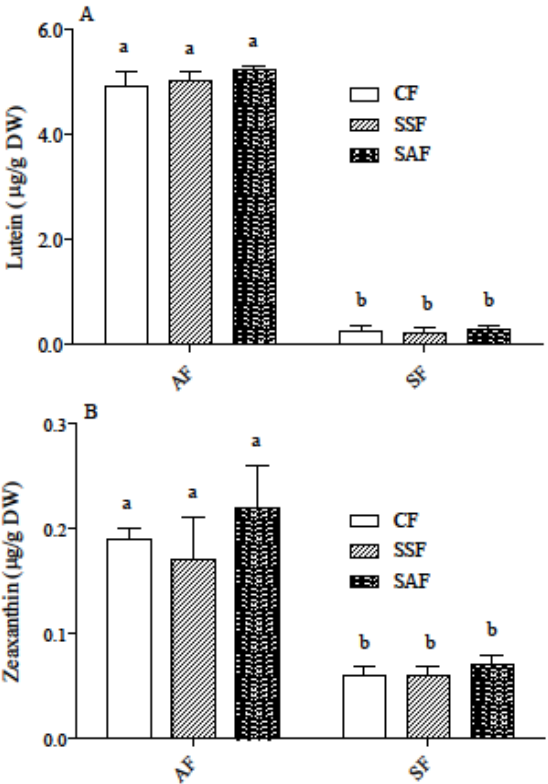
Figure 2. Lutein ( A ) and zeaxanthin ( B ) content in AF and SF breads prepared by CF or SSF or SAF as the starter flour. Results are the mean ± SD of two independent experiments with duplicate samples. Different letters indicate significant differences at p < 0.05. AF = ancient flour; SF = standard flour; CF = conventional fermentation; SSF = sourdough obtained from standard flour; SAF = sourdough obtained from ancient flour.